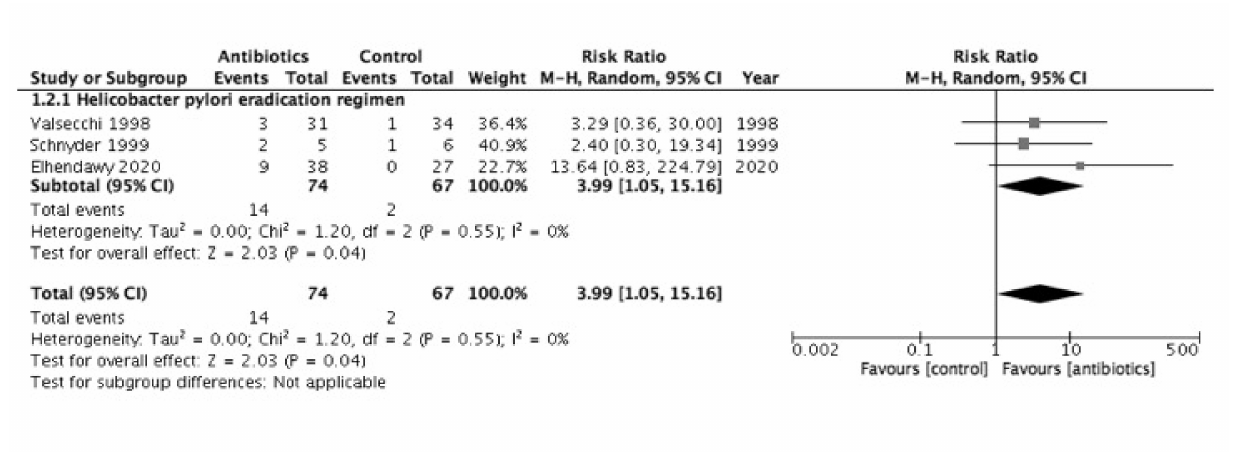
Figure A2. Forest plot of the remission rate including only studies of the participants who completed the study with full data.